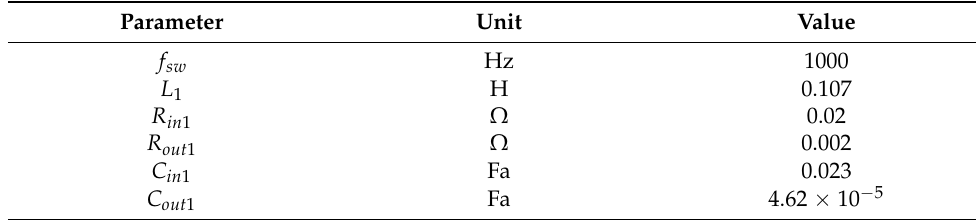
Table 2. Main input parameters of DC/DC buck converter.